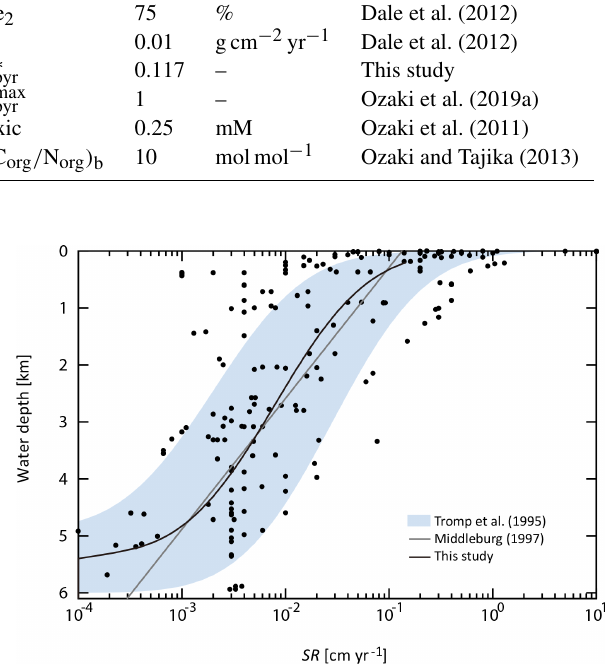
Figure 6. Burial efficiency of organic carbon (BE org ) as a func- tion of sedimentation rate (SR). The dots denote the observational data compiled from literature survey (Betts and Holland, 1991; Canfield, 1993; Henrichs and Reeburgh, 1987; Tromp et al., 1995; Hartnett et al., 1998). The color represents the O 2 concentration of bottom water, [O 2 ] bw , with gray dots for the unknown [O 2 ] bw value. Blue and red lines are the relationship for well-oxygenated ([O 2 ] bw > 200µM) (Henrichs and Reeburgh, 1987) and anoxic ([O 2 ] bw < 30µM) marine sediments adopted in the CANOPS-GRB model, whereas the solid gray line is a previously proposed empiri- cal relationship of Betts and Holland (1991).